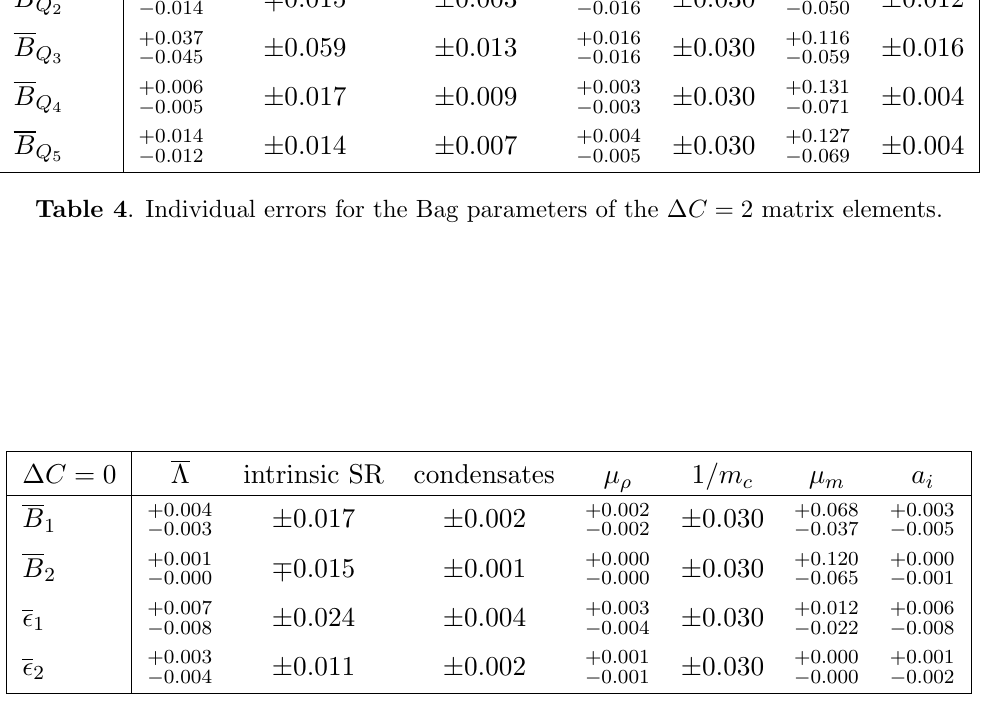
Table 5 . Individual errors for the Bag parameters of the (cid:1) C = 0 matrix